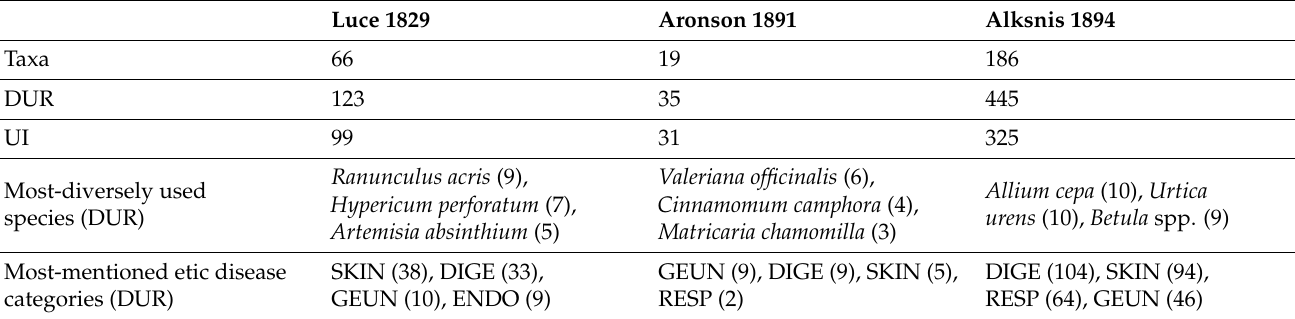
Table 2. Comparison of the three authors.